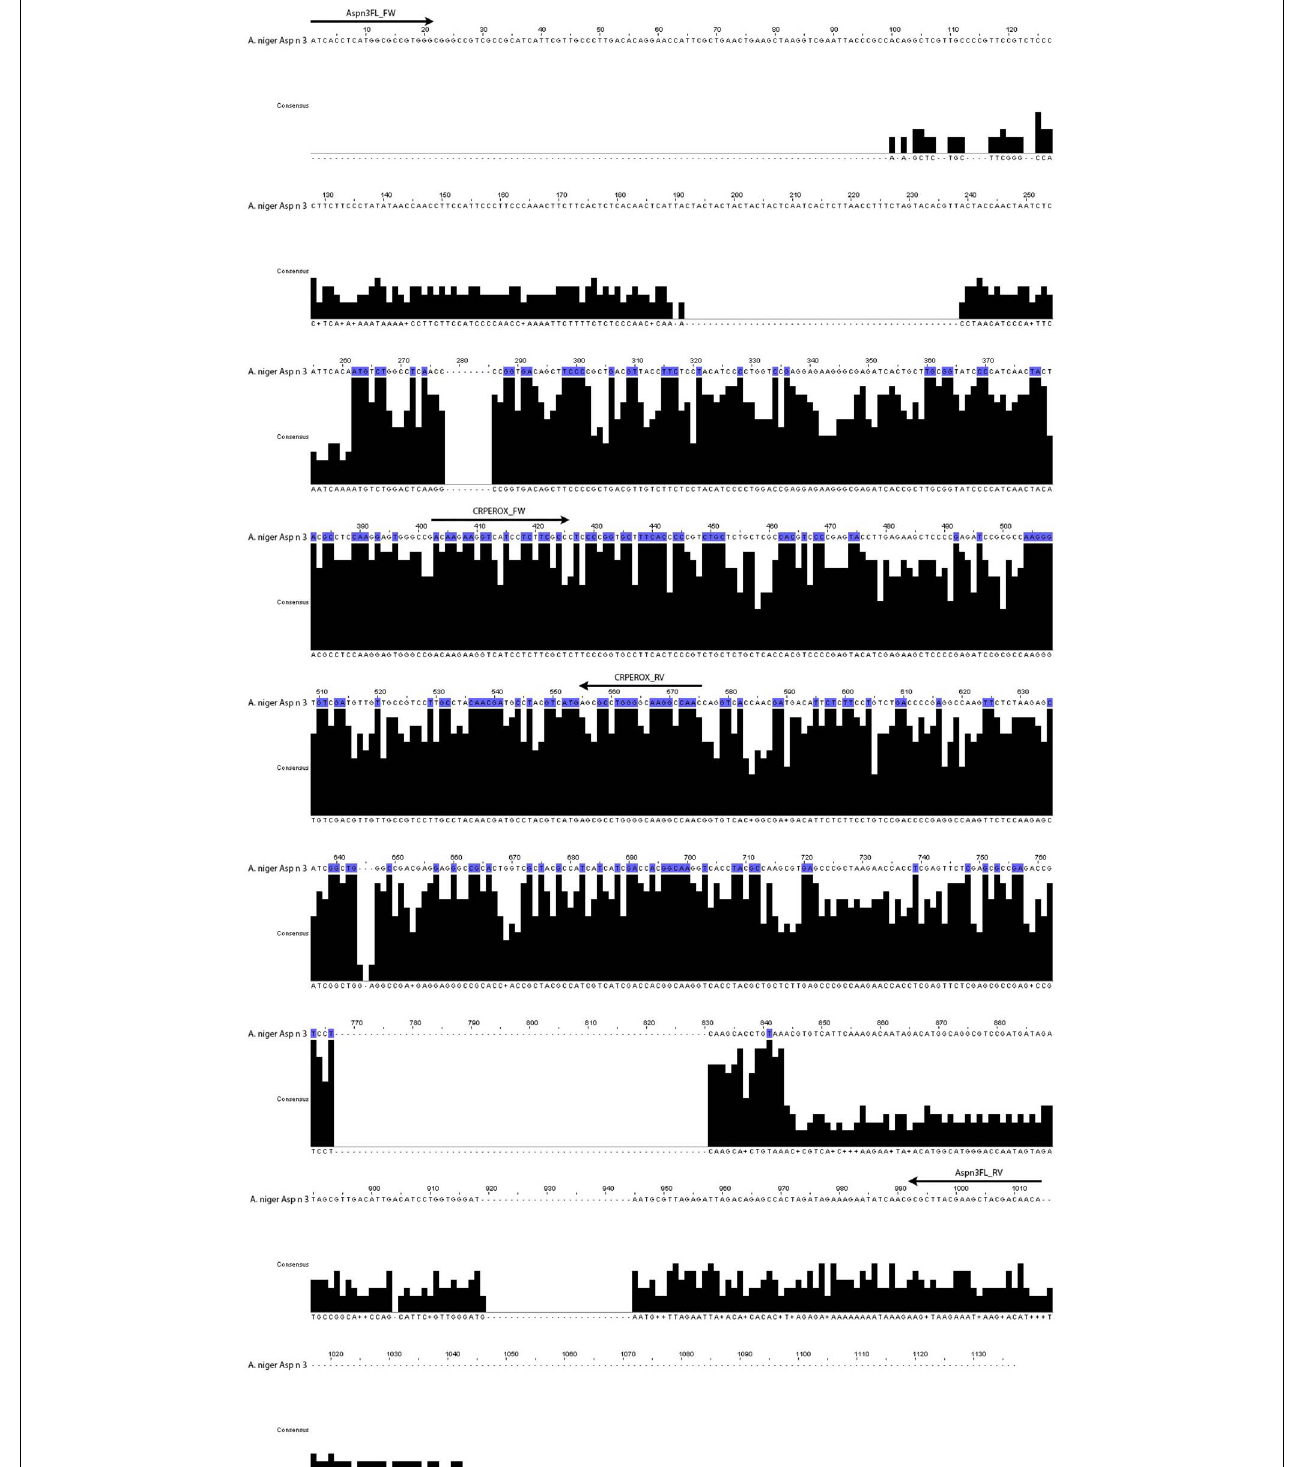
FIGURE 1 | Complete sequence of the gene that codifies for the allergen Asp n 3 compared to the consensus sequence of the fungal species considered in the design ( A. niger , A. fumigatus , A. terreus , A. clavatus , A. nidulans , A. flavus , A. oryzae , Penicillium citrium , P. chrysogenum , Trichophyton rubrum , and Neurospora crassa ). The arrows indicate the position of the two pairs of primers corresponding to complete cDNA gene and conserved region.